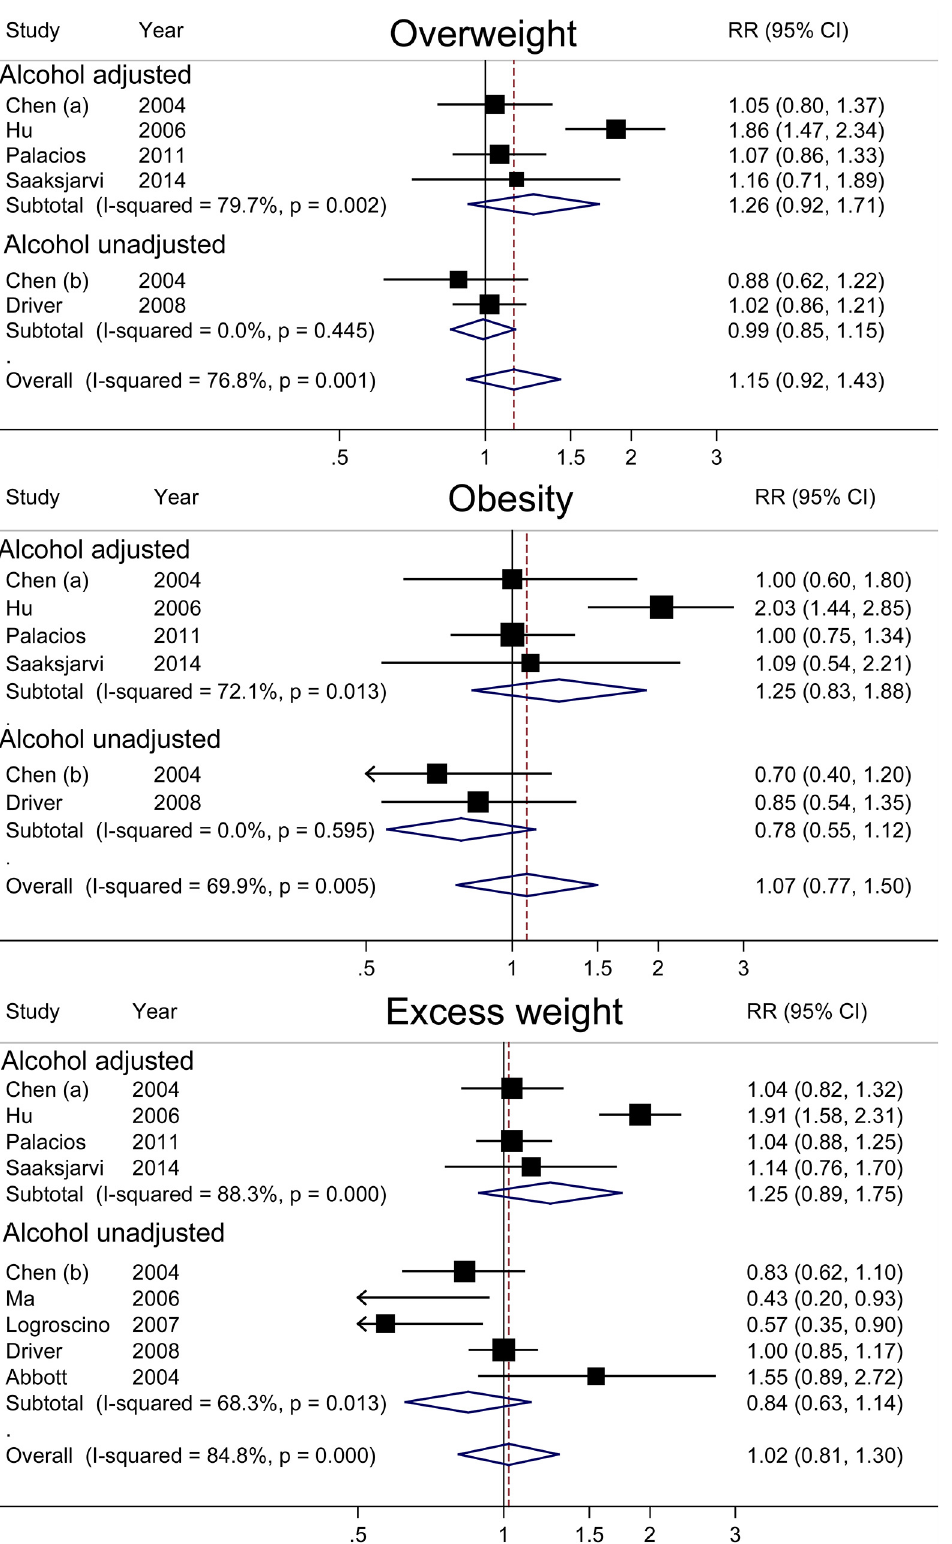
Fig 3. Relative risks and 95% confidence interval of Parkinson ’ s disease associated with overweight, obesity and excess weight, by adjustment for alcohol consumption. doi:10.1371/journal.pone.0131778.g003 PLOS ONE | DOI:10.1371/journal.pone.0131778 June 29,